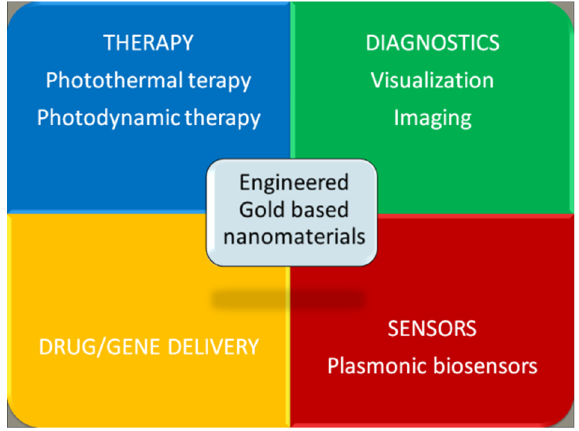
Figure 2. A schematic representation of the four main areas of biomedical applications for engineered gold-based nanomaterials.